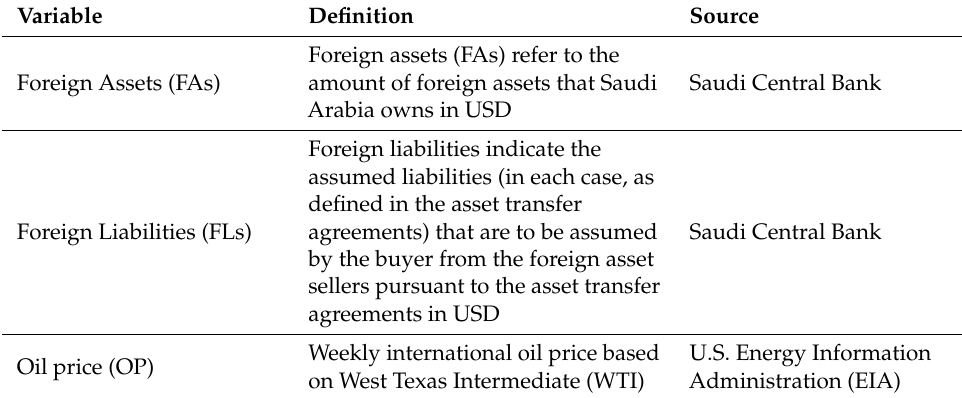
Table 1. Description of variables.